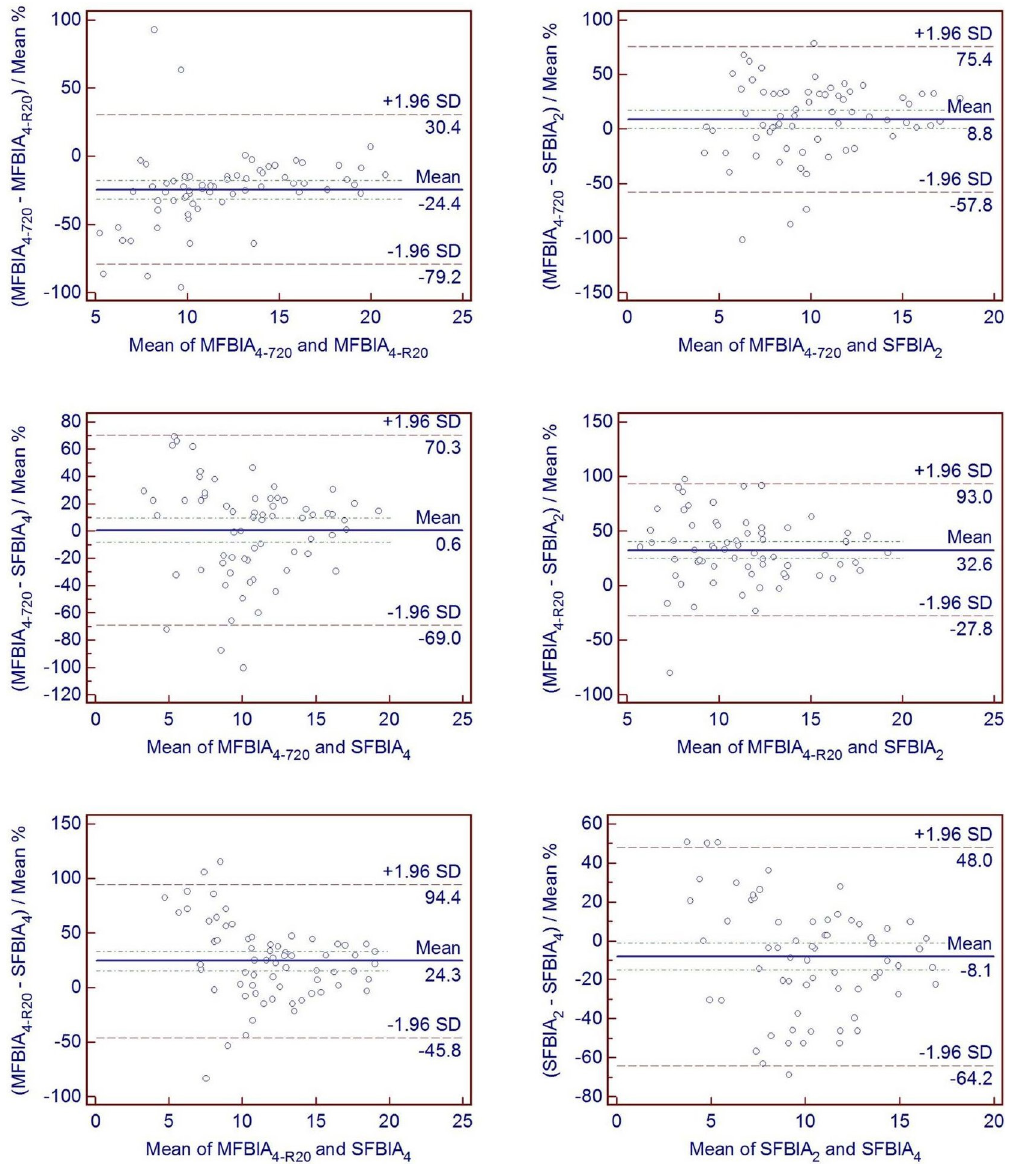
Bland-Altman plots with 95% limits of agreement and correlation analysis of the differ- ences between the body fat values measured by the used analyzers in percentage –